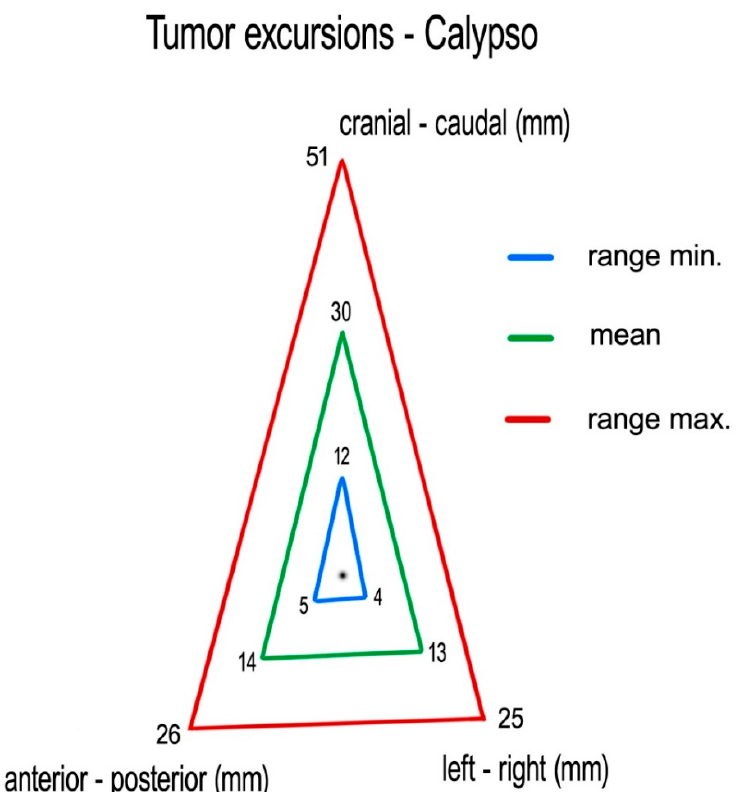
Figure 5. Mean tumor excursions (with range max/min), as recorded with Calypso ® . Measuring the 4D-CT study sets, we found following medians (means) of tumor ex- cursions in the corresponding directions: CC: 19 (19) mm (ranging 6–35 mm), AP: 9 (9) mm (ranging 0–21 mm), and LR: 9 (10) mm (ranging 3–27 mm) (Figure 6).